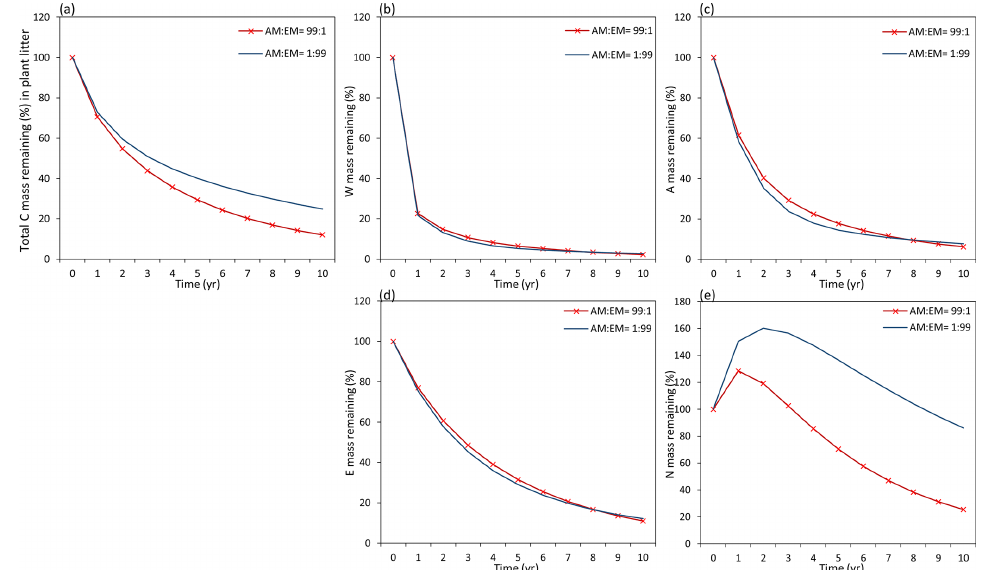
Figure D1. Dynamics of plant root litter decomposition in AM-dominated vs. EM-dominated environments. (a) Loss of total carbon mass from root litter. (b, c, d) Dynamics of loss of labile carbon components ( W – water-soluble C pool, A – acid-hydrolysable C pool, E – ethanol-soluble C pool). (e) Dynamics of loss of recalcitrant (non-hydrolysable) carbon ( N pool). The initial W , A , E , and N composition